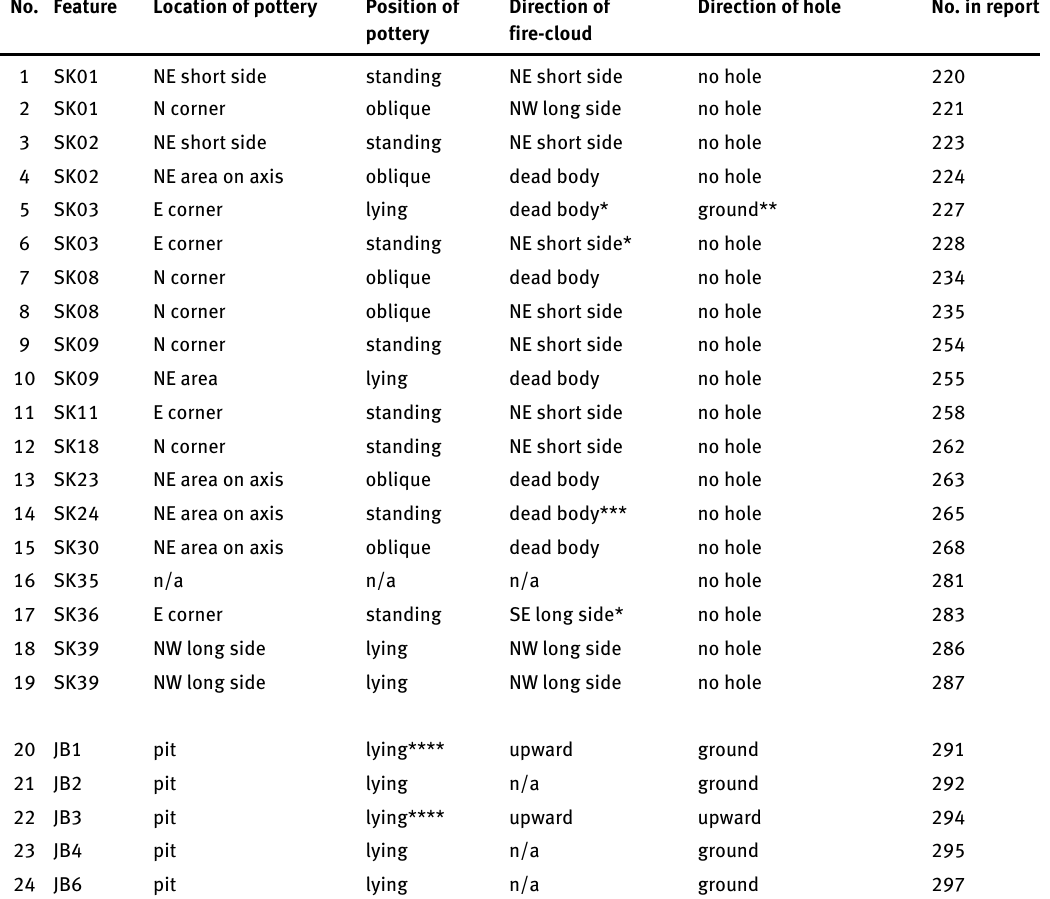
Table 1. Offering vessels and burial jars excavated at the Mochida-Cho San-Chome site which formed the subject of the colla- tion analysis